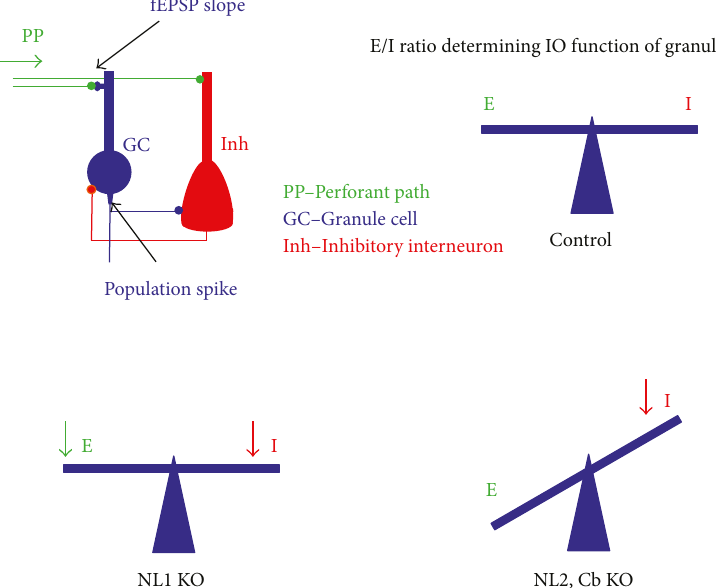
Figure 6: Summary of the e ff ects of NL1, NL2, and Cb deletion on E/I ratio and granule cell I/O function. Whereas deletion of NL1 does not change output fi ring of granule cells, deletion of NL2 and Cb leads to enhanced granule cell output (see text for details).